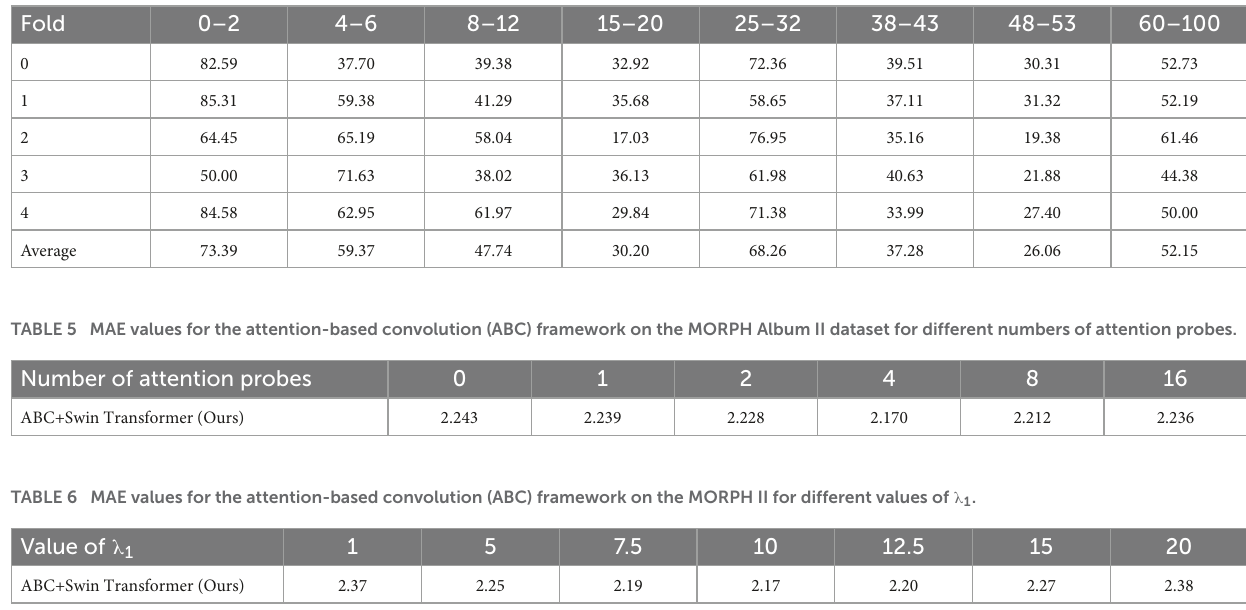
TABLE 4 Accuracy of each age class on the Adience dataset.